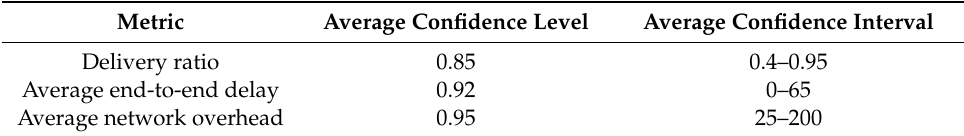
Table 4. The average confidence interval of MSNN with the number of nodes increases 100 to 700.